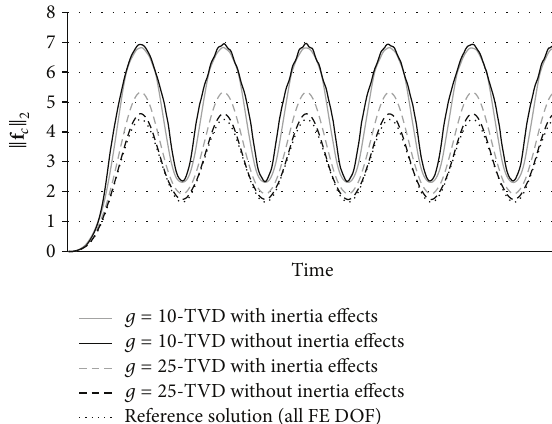
Figure 10: Comparison of the results computed by TVD with and without consideration of inertia effects.